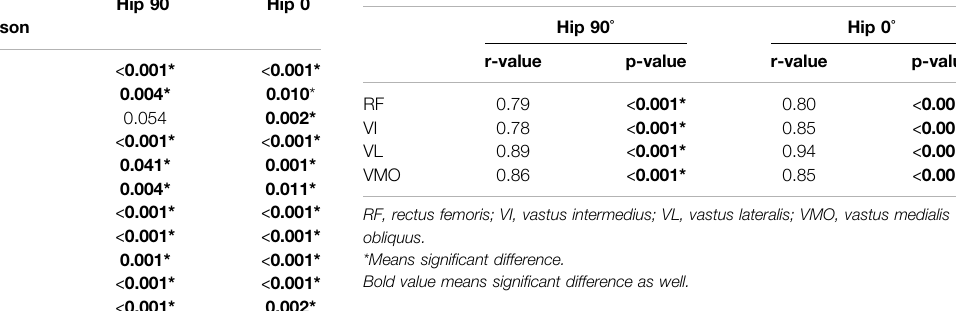
TABLE 3 | The relationship between quadriceps shear modulus and relative muscle contraction level (% MVIC).